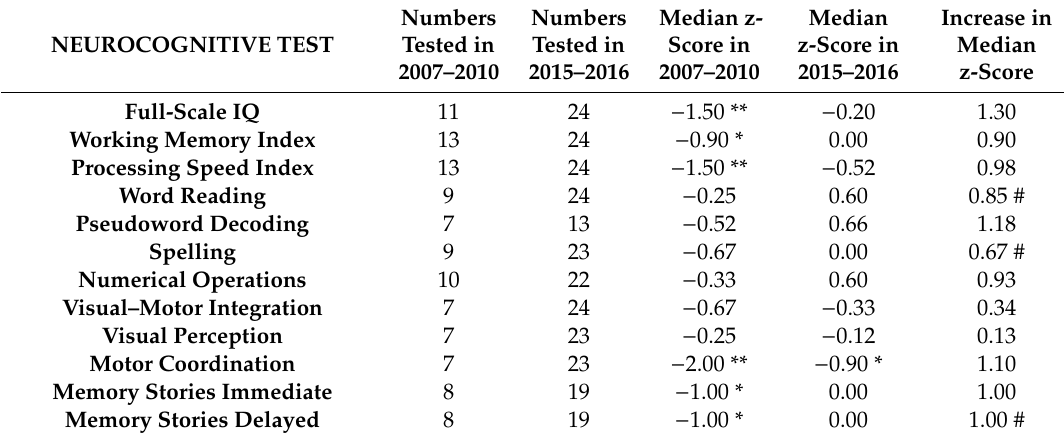
Table 2. Results for all neurocognitive tests